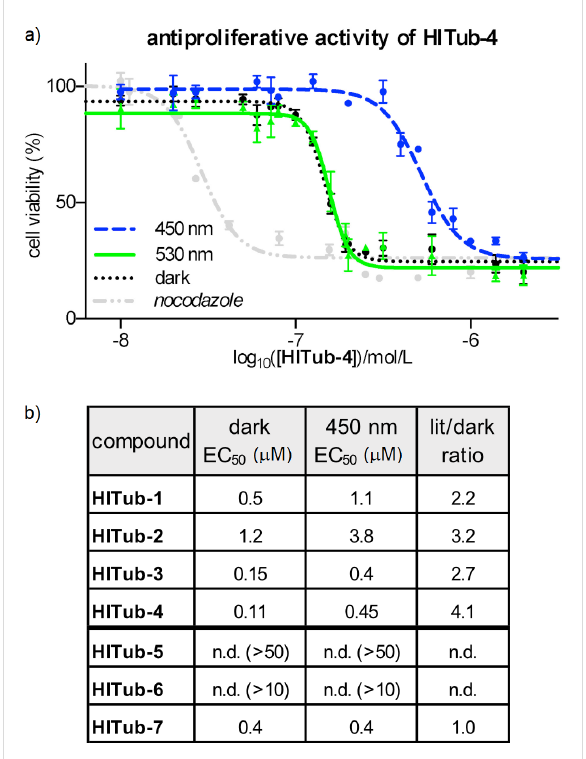
Figure 4: a) Resazurin reduction assay for HITub-4 and nocodazole in HeLa cells ( n = 3), demonstrating the difference in antiproliferative po- tencies at λ = 450 and 530 nm/dark conditions (75 ms pulsing every 15 s). b) EC 50 values of HITubs from cellular antiproliferation